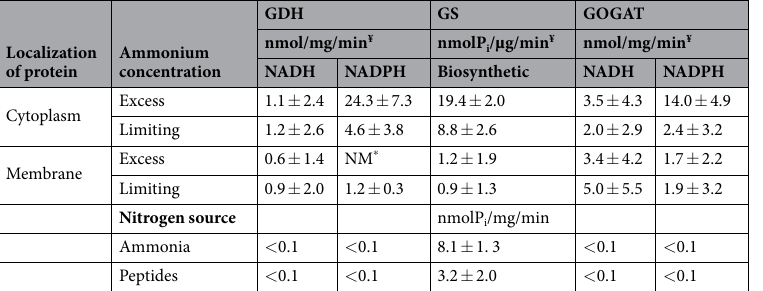
Table 2. Effect of growth on different concentrations of ammonia or peptides in enzyme activities involved in ammonia assimilation in P. ruminicola strain 23. ( * ) NM, no activity was detected (¥) Average values from three technical replicates per